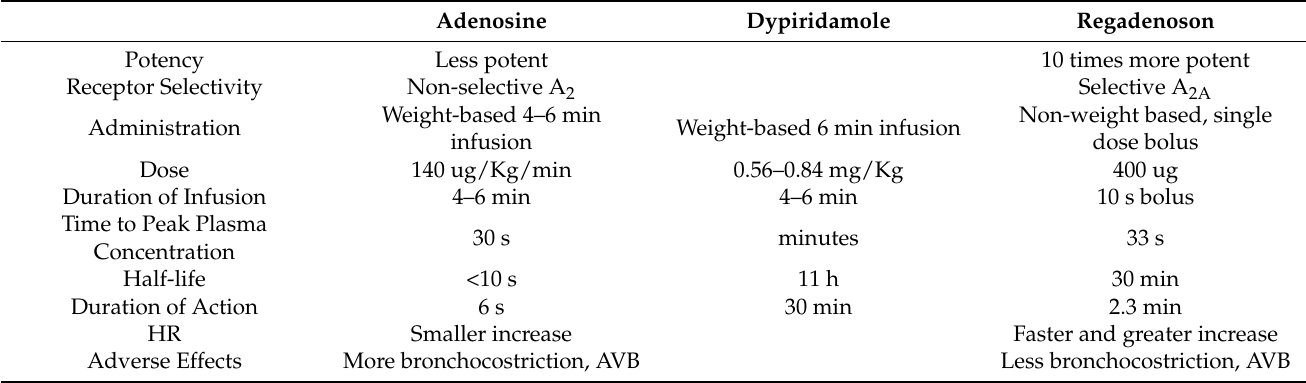
Table 1. Vasodilator agents used for stress